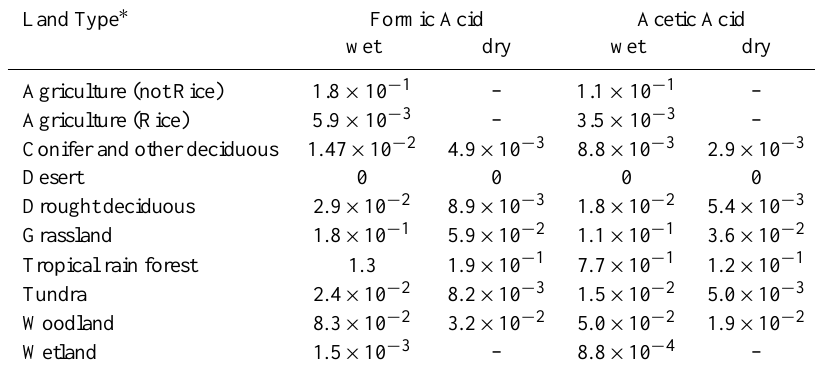
Table 2. Soil emissions of formic and acetic acids at T soil =30 ◦ C in nmol(m − 2 s − 1 ) for different land